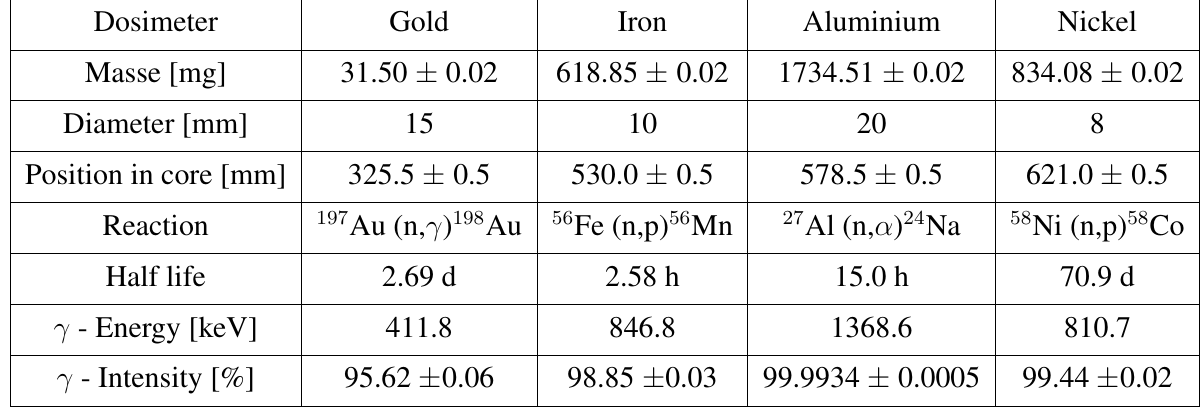
Table 1: Dosimeter description